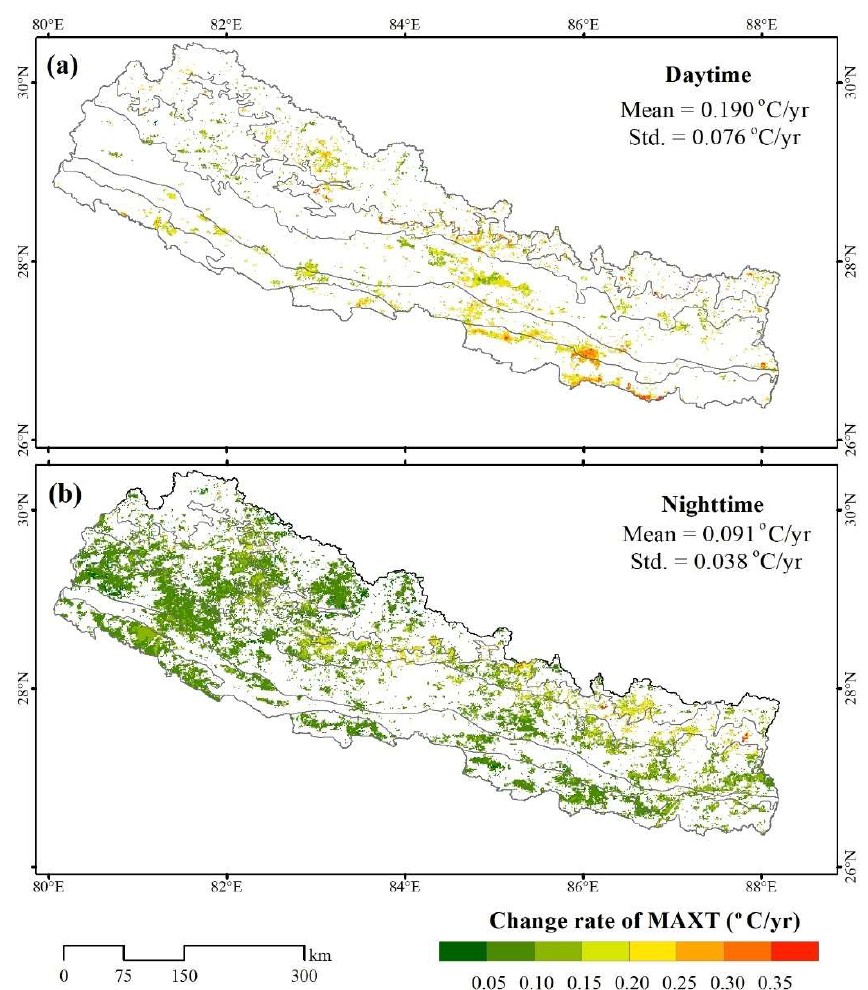
Figure 7. Change rates in significant changing areas of the ( a ) daytime MAXT and ( b ) nighttime MAXT during the period from 2000 to 2017.